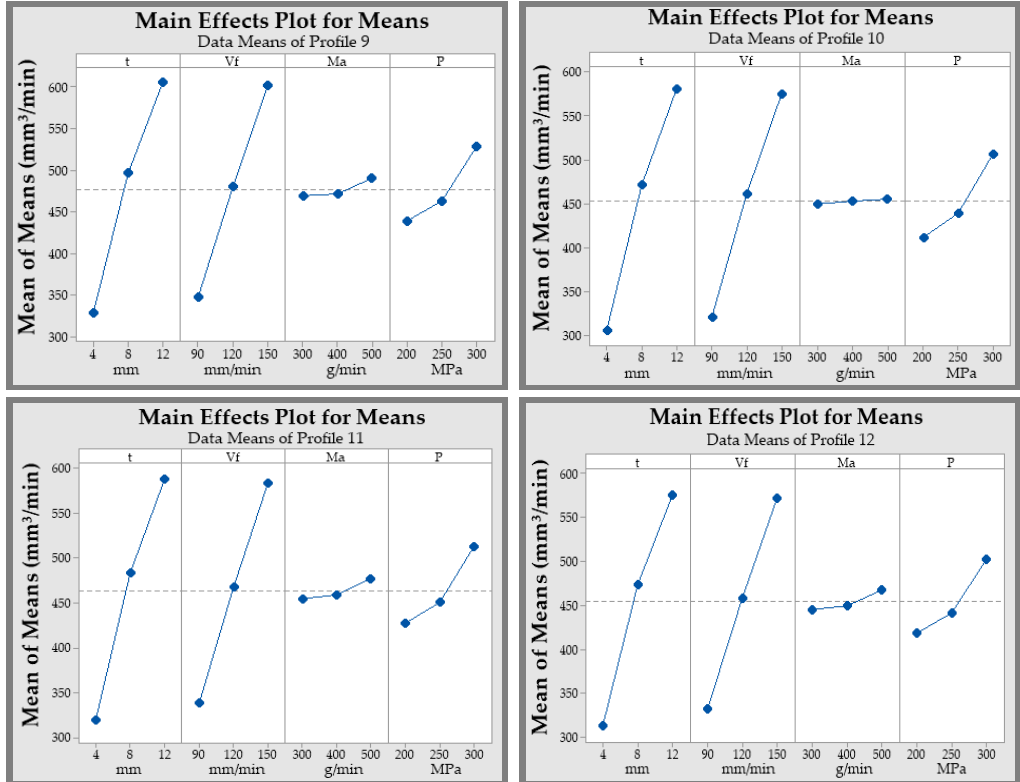
Figure 14. Main effect plot of means for material removal rate against input parameters.